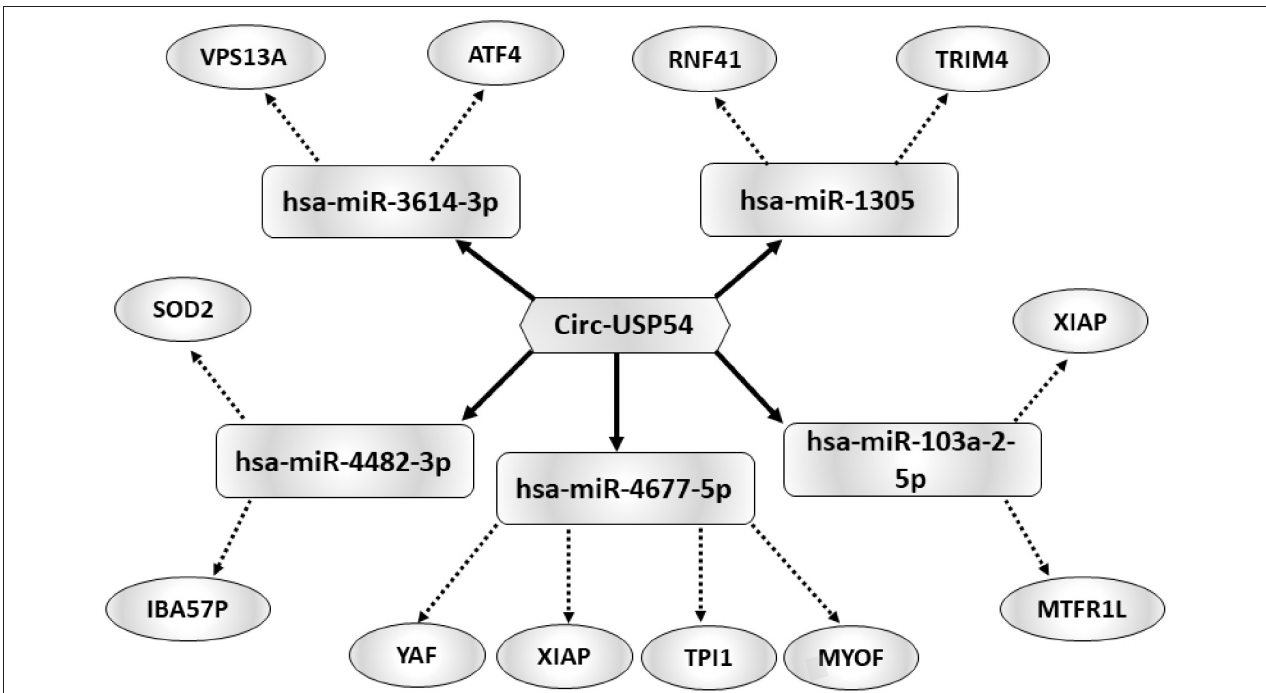
FIGURE 5 | Functional clustering of DE-circRNA down-regulated in B compared to A asthenozoospermic derived SPZ. One circRNA, circUSP54 , tethers a group of miRNAs as targets, all involved in mitochondria-dependent pathways. Networks were built using Cytoscape. Hexagonal and rectangular symbols represent circRNAs and miRNAs, respectively. The arrow indicates the tethering activity of circRNAs toward miRNAs, while the dotted arrow indicates the pathways upstream of the